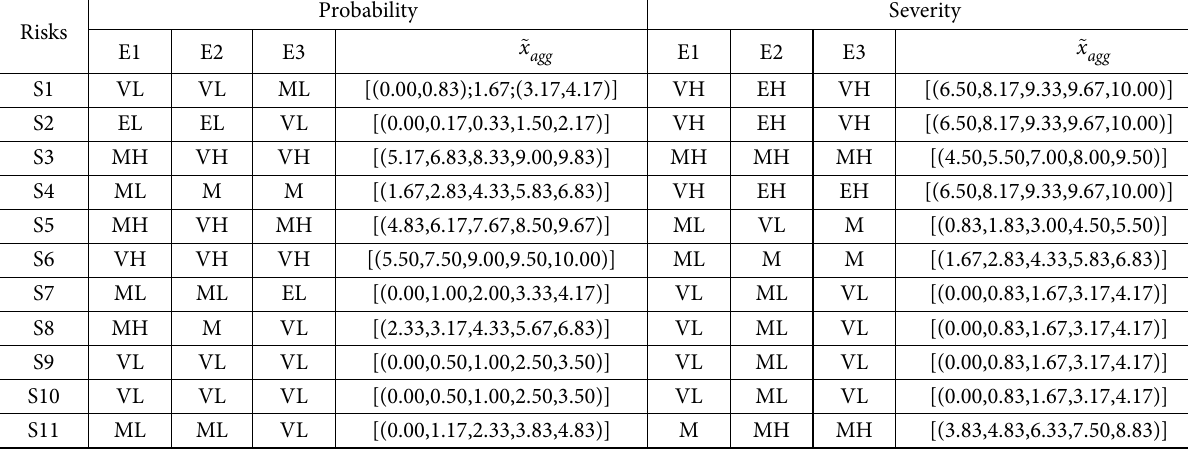
Table 5. Evaluations of the risks with respect to the two risk